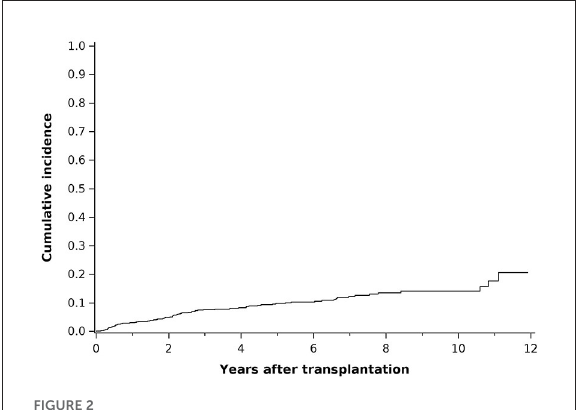
FIGURE2 Cumulative incidence curve of cancers (all sites included) occurring after transplantation in PLT patients.